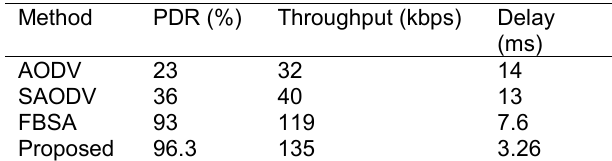
Table 4. Efficiency of proposed work in data